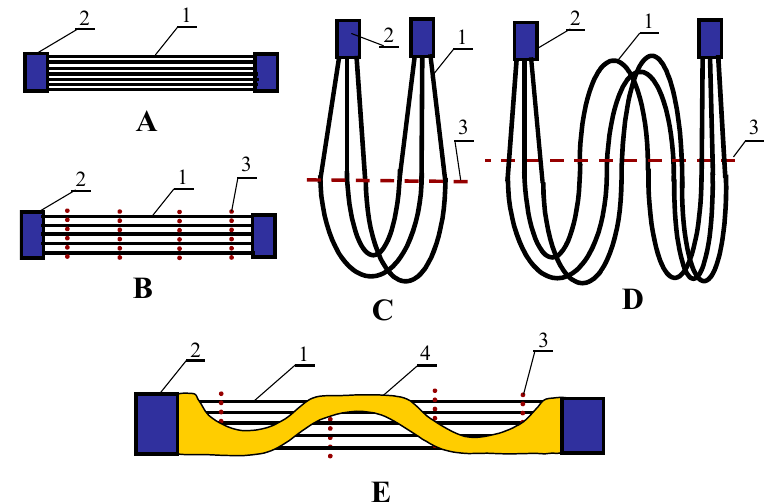
Figure 4. Various constructions of submerged MD module. ( A ) statistical arrangement of capillaries; ( B ) capillaries located inside the nets; ( C ) U-shape type, membranes located inside the net; ( D ) multiple U-shape; ( E ) variant 3B stiffened by tubular housing with cut out large holes. 1—capillary membrane, 2—module head, 3—PP grid, 4—tubular housing with holes. Table 1. Commercial capillary membranes assembled in submerged MD modules. Membrane parameters—manufacturers’ data.